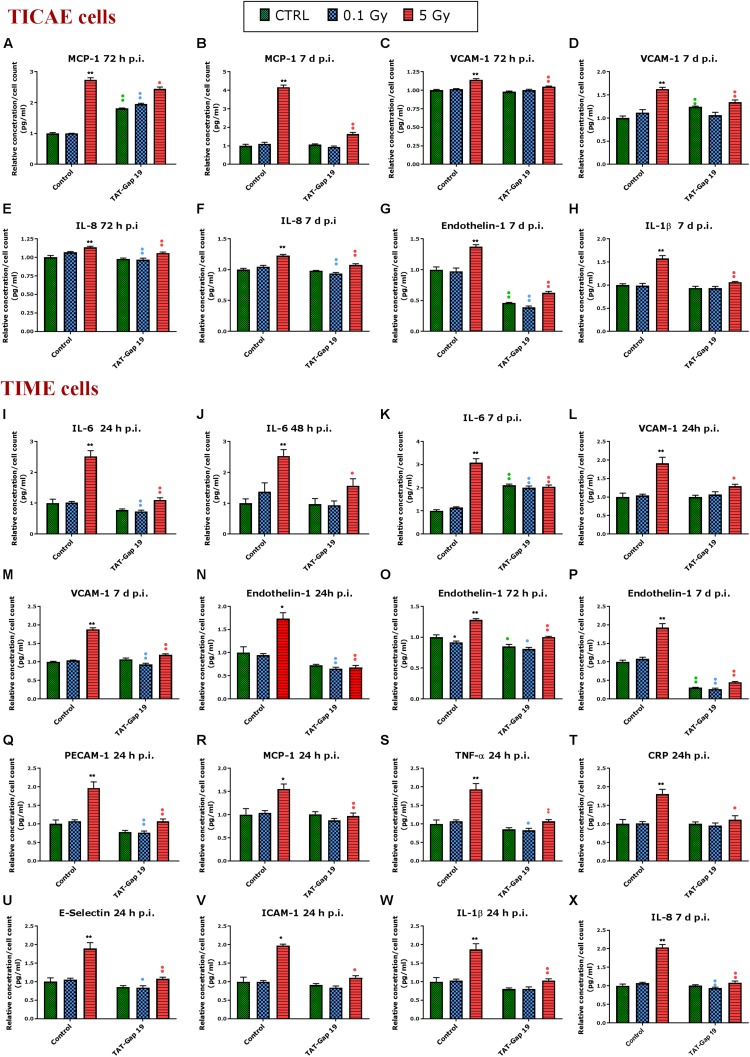
Radiation-induced inflammatory responses and the effect of TAT-Gap19. The response of various inflammatory markers in (A–H) TICAE cells and (I–X) TIME cells to 0.1 and 5 Gy irradiation conditions. The values represent the average ± SEM of 5–6 biological replicates; data were analyzed with a non-parametric Mann–Whitney T-test. *Indicates statistical differences compared to the respective 0 Gy controls. •Indicates statistically significant differences between the TAT-Gap19 group compared to the corresponding responses in the control group (not-treated with TAT-Gap19). */•p < 0.05; **/••p < 0.01. IL-1β, Interleukin 1 beta; IL-6, Interleukin 6; IL-8, Interleukin 8; ICAM-1, Intracellular adhesion molecule 1; VCAM-1, Vascular cell adhesion protein 1; PECAM-1, Platelet endothelial cell adhesion molecule-1; MCP-1, Monocyte chemotactic protein-1; TNF- α, Tumor necrosis factor alpha; CRP, C-reactive protein.